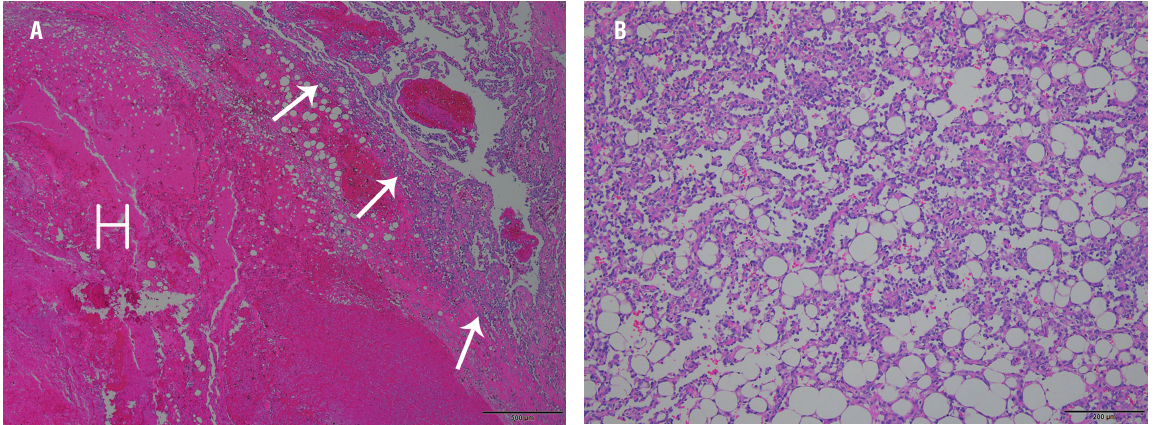
Figure 3 - Histological sections reveal hematoma (H) and anastomosing channels with obvious vasoformation and dissecting growth pattern (arrows) (A: H & E stain, x 40) and complex anastomosing channels with endothelial papillae (B: H & E stain, x